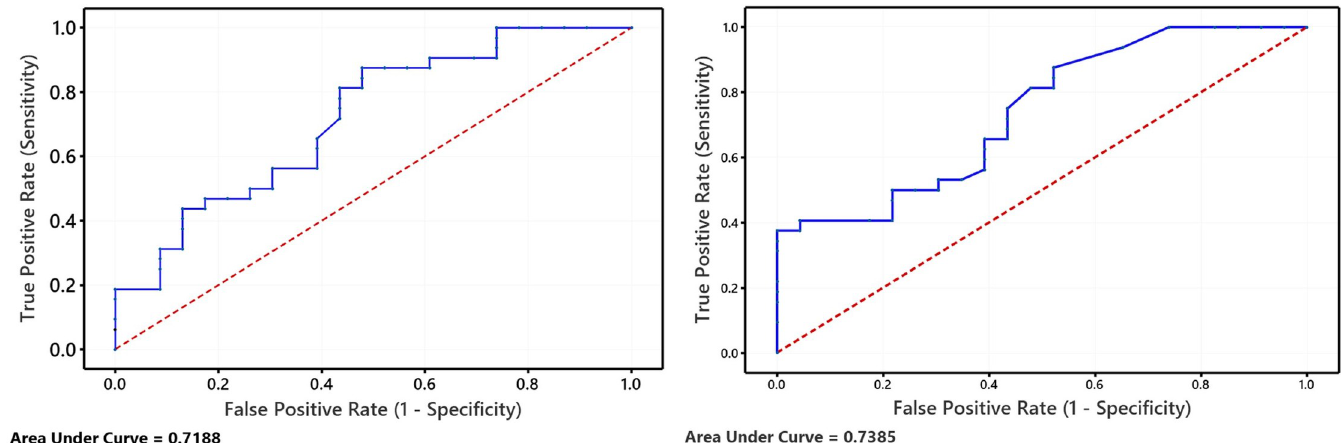
Fig 2. Receiver operating characteristics (ROC) curves of the RA patients in the study. EgyDAS (left) and DAS28 (right).